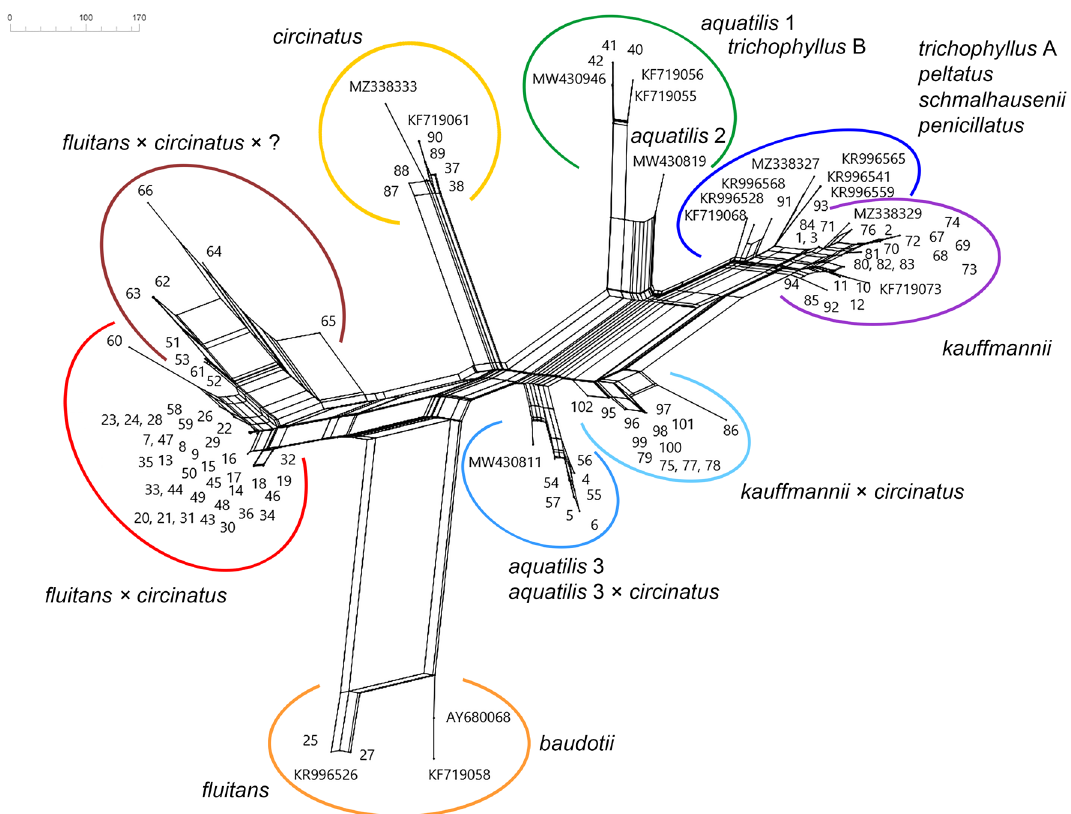
Figure 2. NeighborNet analysis of ITS variability within Batrachium studied samples and some additional species. Numbers correspond to sample numbers in Supplementary data: Table S1 and GenBank accession numbers. Hybrid names were given regarding the crossing direction: maternal species × paternal